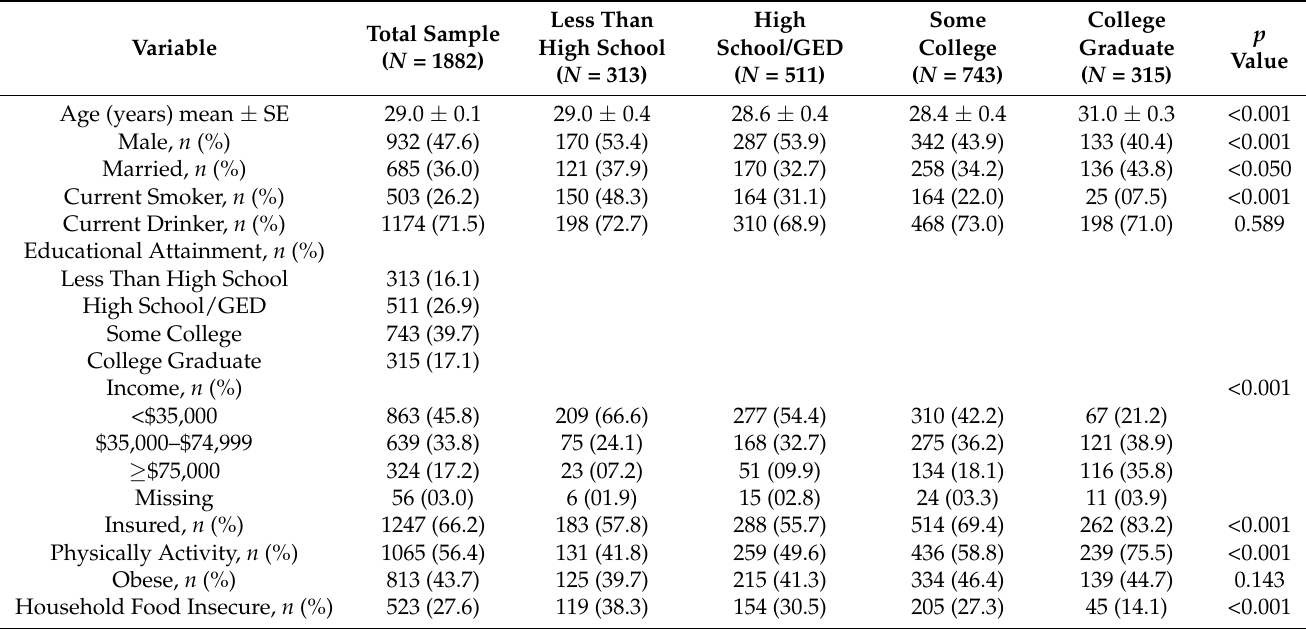
Table 1. Demographics, educational attainment, household food insecurity, and obesity among Black young adults of ages 20–39; NHANES 2007–2016.